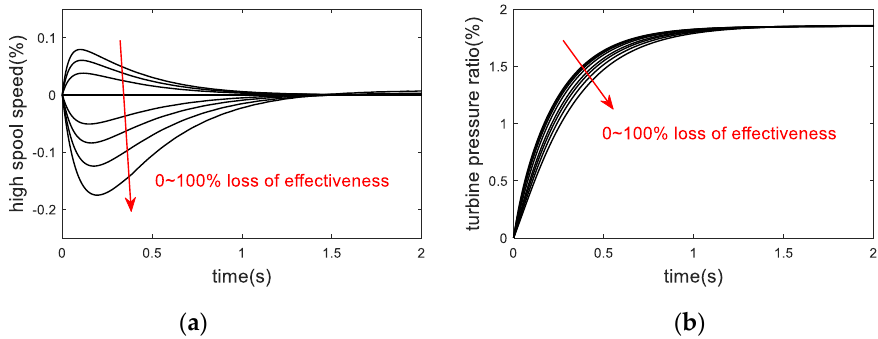
Figure 8. FTC result of adaptive SMC (ASMC) design-controlled variables. ( a ) n h ( b ) π t